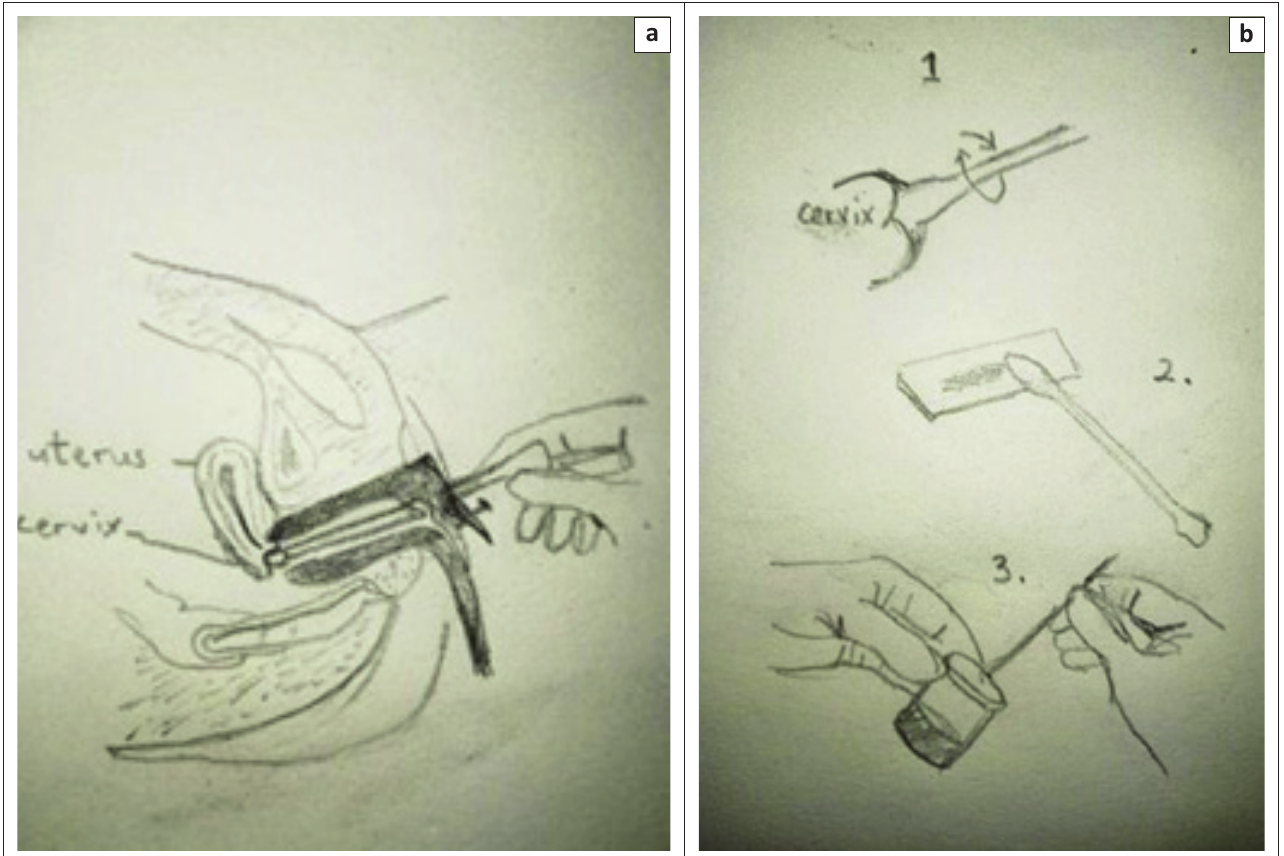
FIGURE 2: Steps for taking a cervical smear. a) Inserting speculum and spatula; (b) 1. 360 degree smear; 2. Apply Ayres spatula to slide or 3. break off end of the brush into cytology fluid.